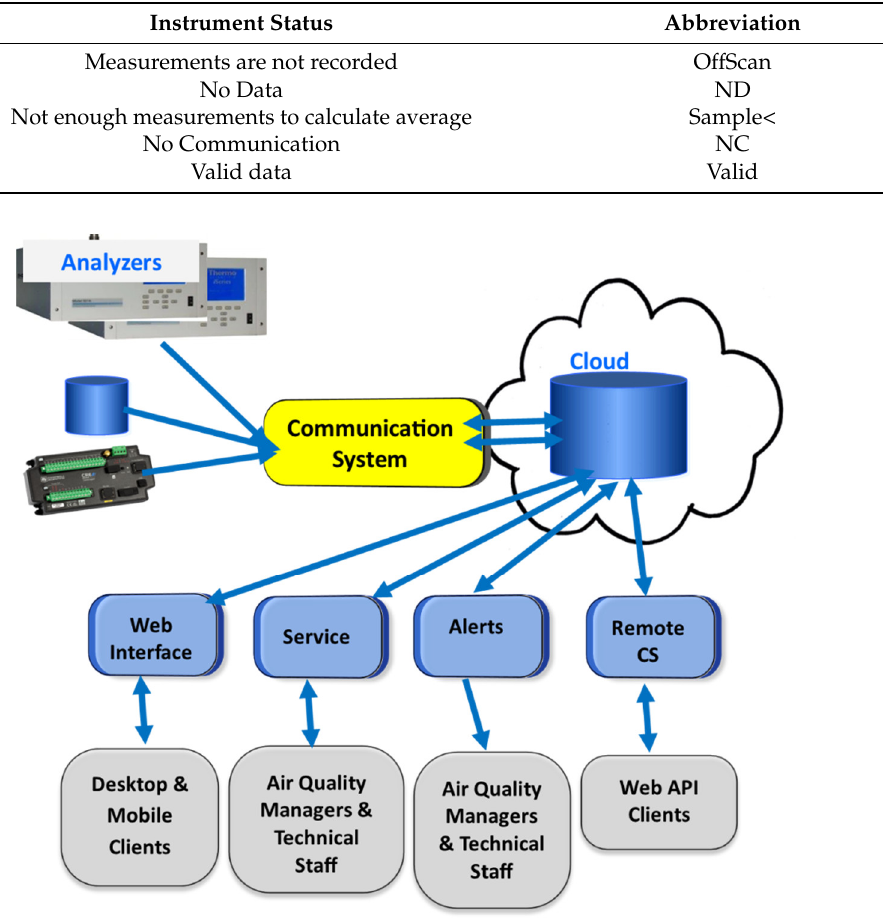
Figure 1. Workflow Diagram of AirDMS. Table 1. Abbreviation status explanation (flags).